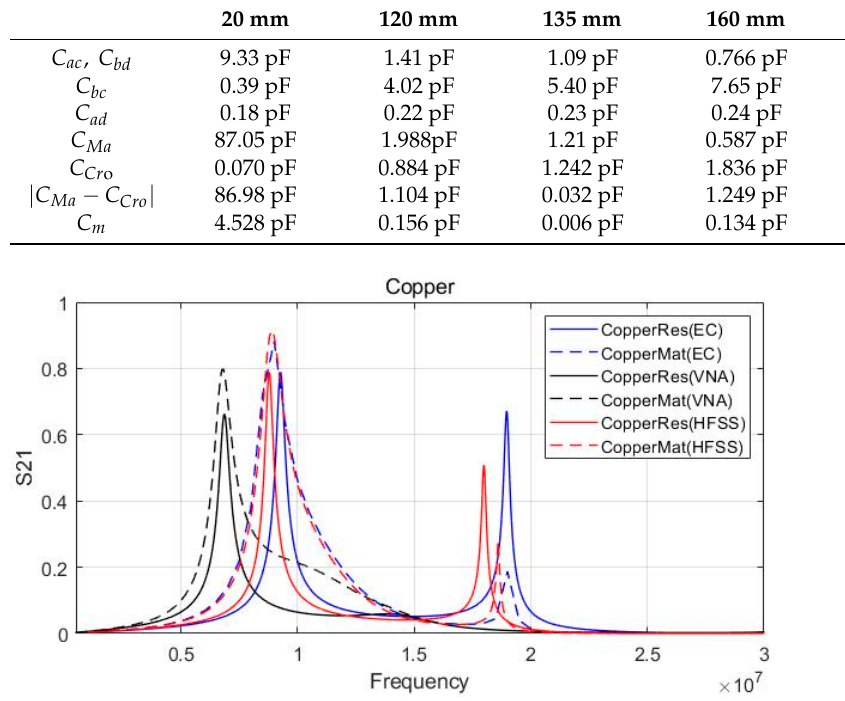
Figure 9. Experimental and simulation result (copper plate).